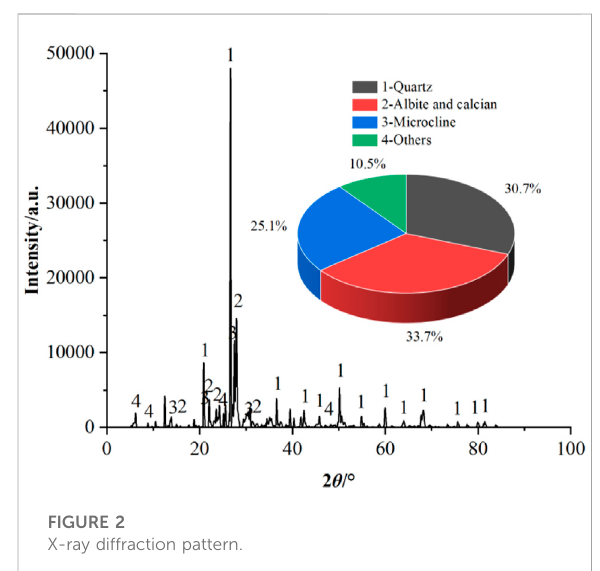
FIGURE 2 X-ray diffraction